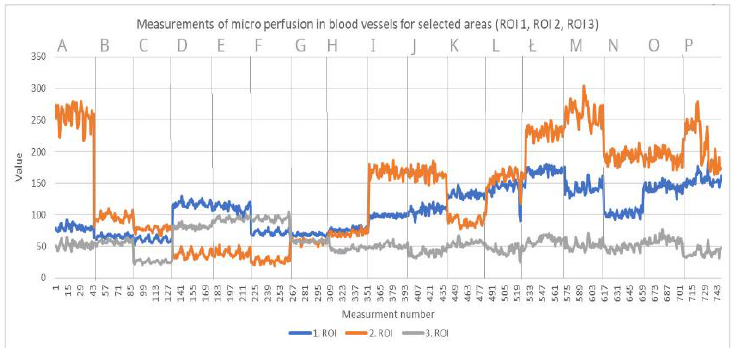
Figure 6. Measurements of microperfusion in blood vessels in selected areas — Case 1. Legend: ROI — Region of interest.